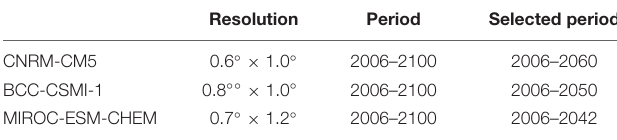
spurious records (Wang et al., 2013). In addition, data availability less than 60% were excluded in the